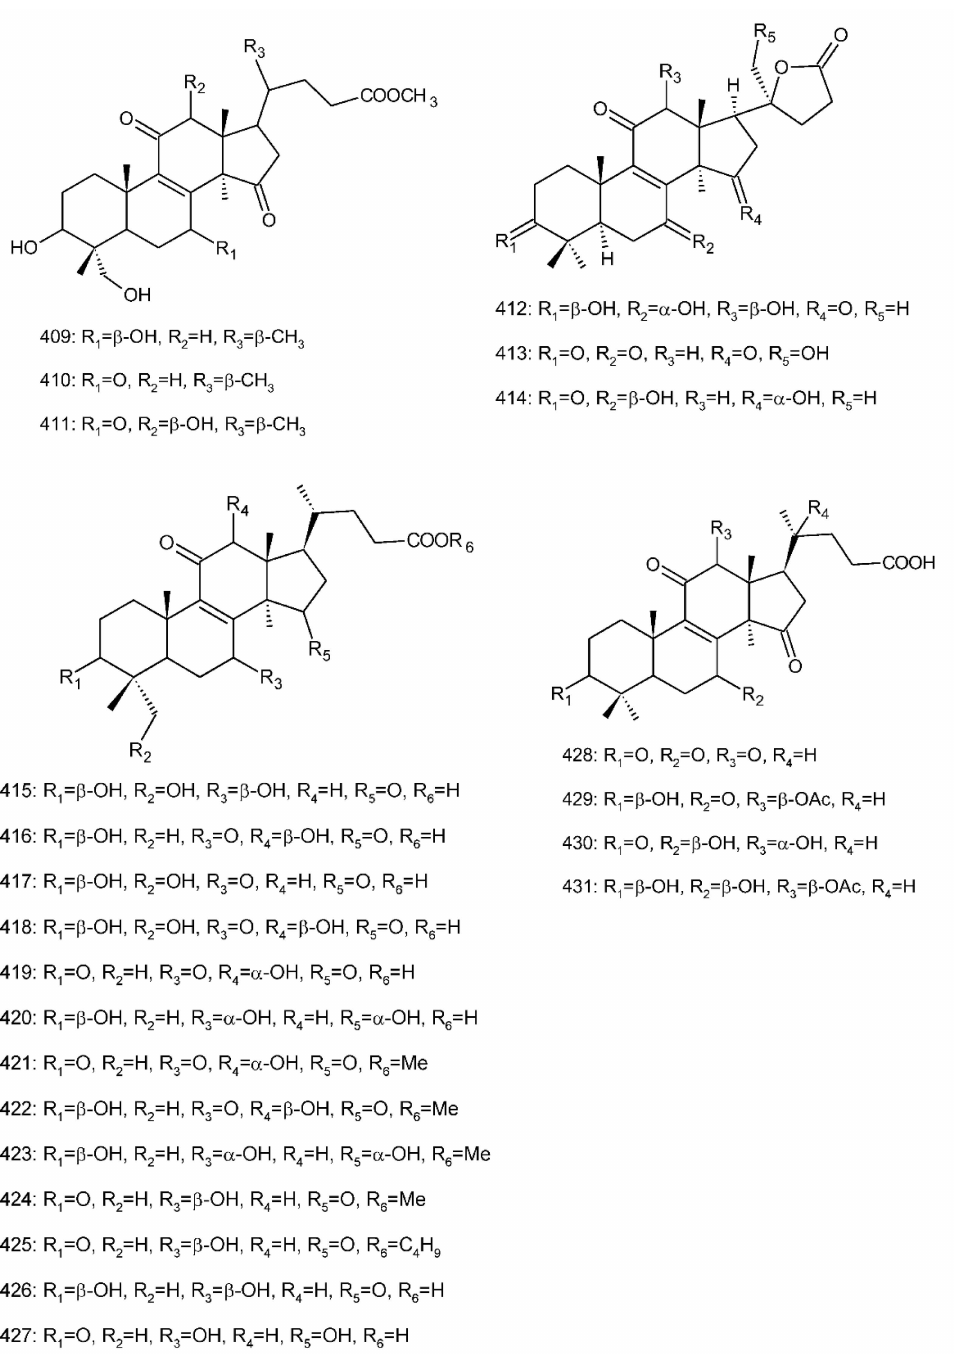
Figure 13. Chemical structures of several C27 triterpenoids ( 364 – 431